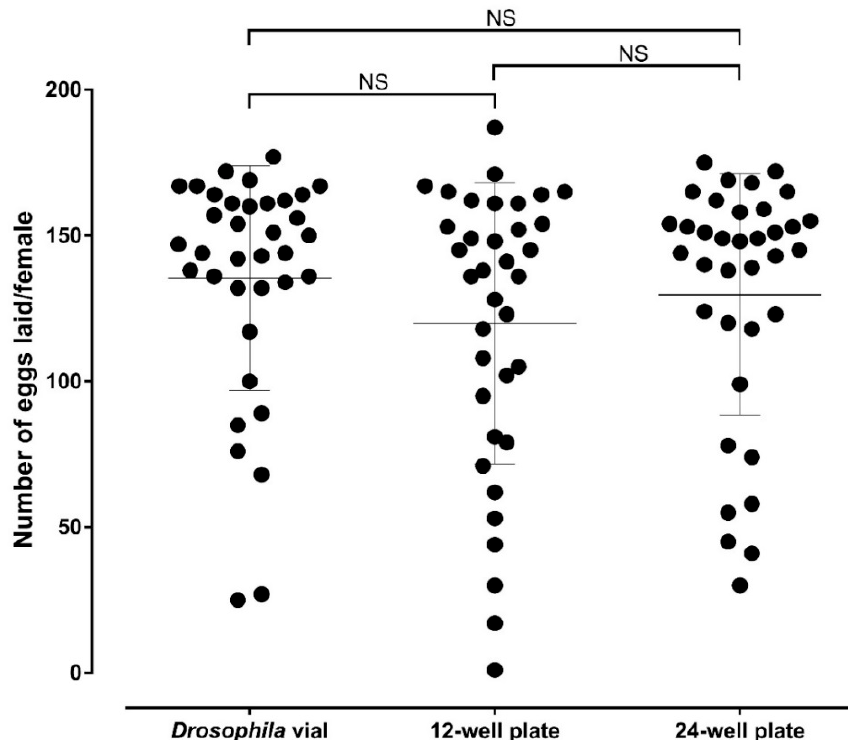
Figure 4. Comparison of the area used to perform oviposition experiments with Drosophila vials device when 72 gravid Ae. aegypti females are required and the proposed oviplates necessary to fit the same number of females. ( A ) The 72 Drosophila vials occupying 4100 cm 3 of insectary space. ( B ) The Drosophila vial set up as an individual oviposition device. ( C ) Three 24-well plate occupying 700 cm 3 . ( D ) Six 12 well plate occupy 1400 cm 3 .